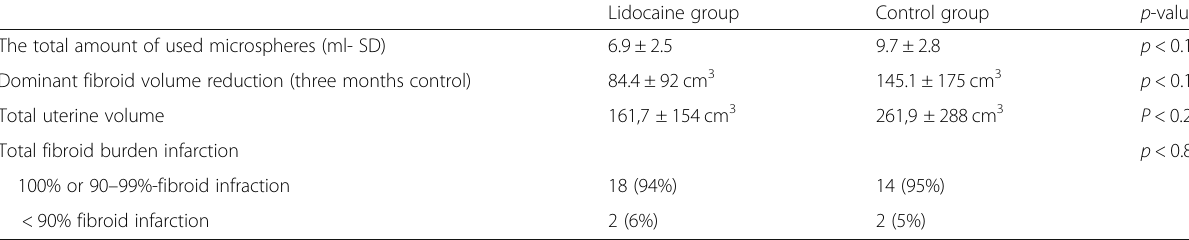
Table 3 Detail about used microspheres and MR three months control results